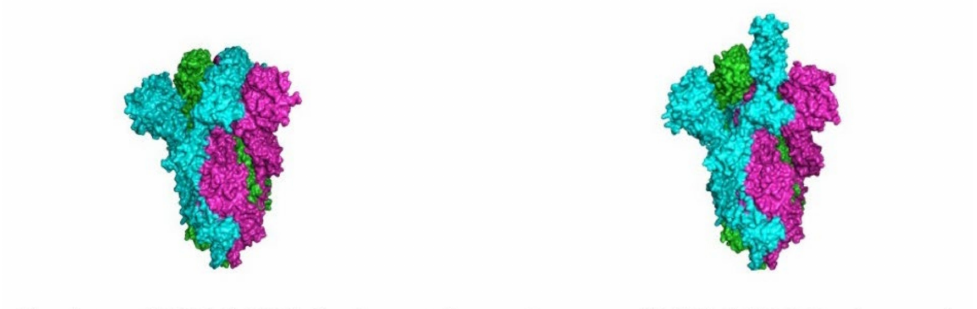
Figure 3. Cryo-EM structure of the SARS-CoV-2 spike glycoprotein. The closed state ( left ) and open state ( right ) of the spike glycoprotein (closed state PDB: 6VXX and open state PDB: